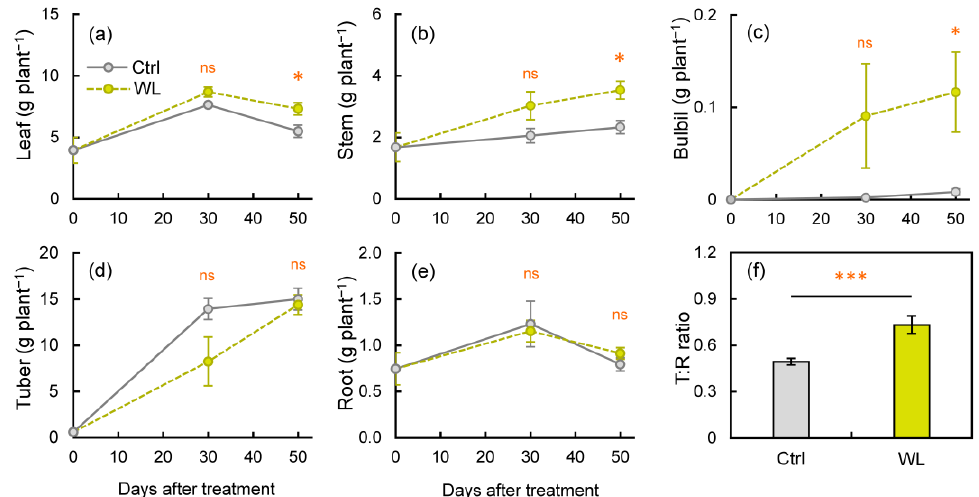
Figure 4. Changes in dry matter production at each organ: ( a ) leaf, ( b ) stem, ( c ) bulbil, ( d ) tuber, and ( e ) root, under control (Ctrl) and waterlogged (WL) soil conditions, as well as ( f ) top/root ratio (T:R ratio) at 50 days after treatment. Values are the means ± S.E. of three to six replications derived from different plants. * p < 0.05, *** p < 0.001; ns, not significantly different (Student’s t -test).